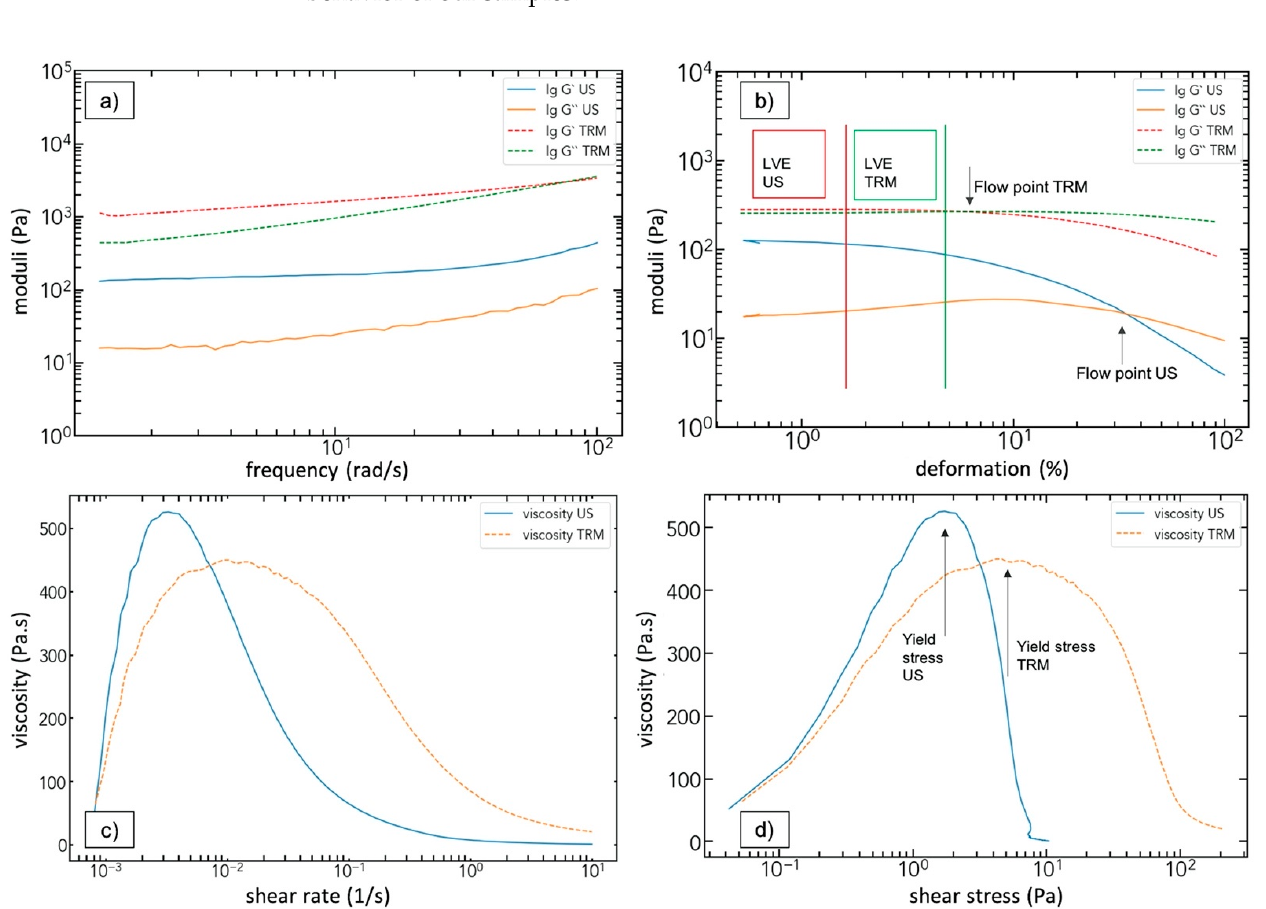
Figure 8. Overview of the different applied rheological tests and the resulting plots shown for the CNT 0.5 wt% US sample: ( a ) frequency sweep and the comparison of US and TRM dispersion; ( b ) amplitude sweep indicating the linear viscoelastic regime (LVE) and the flow point; ( c ) viscosity measurement showing the shear thinning behavior; ( d ) shear stress and the corresponding yield stress.